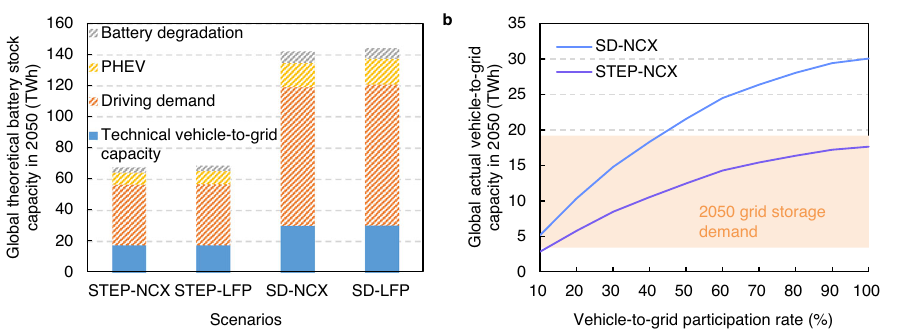
Fig. 3 | Global available vehicle-to-grid capacity in 2050. a Technical vehicle-to- grid capacity. Hatched bars indicate the capacity limits due to key factorsand blue bars the technical vehicle-to-grid capacity. b Real-world vehicle-to-grid capacity as a function of participation rates. Results are shown for the STEP-NCX and the SD- NCX scenarios with a comparison to the range of storage demand computed by